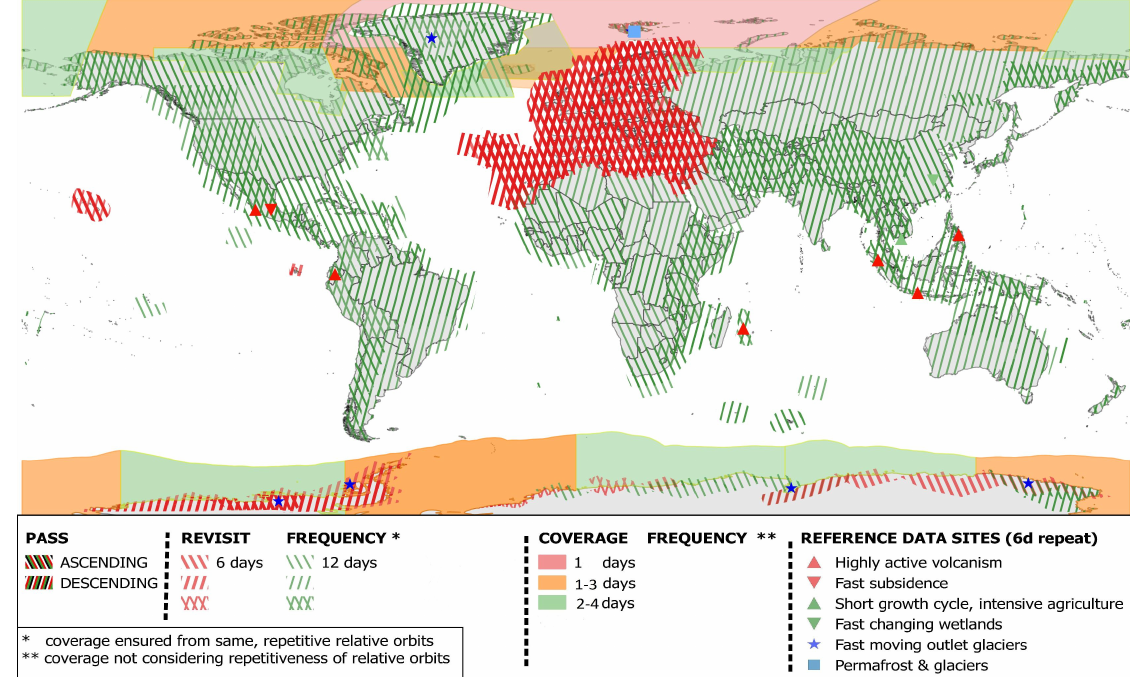
Figure 2. Sentinel-1 constellation observation, revisit and coverage scenario (April 2021)